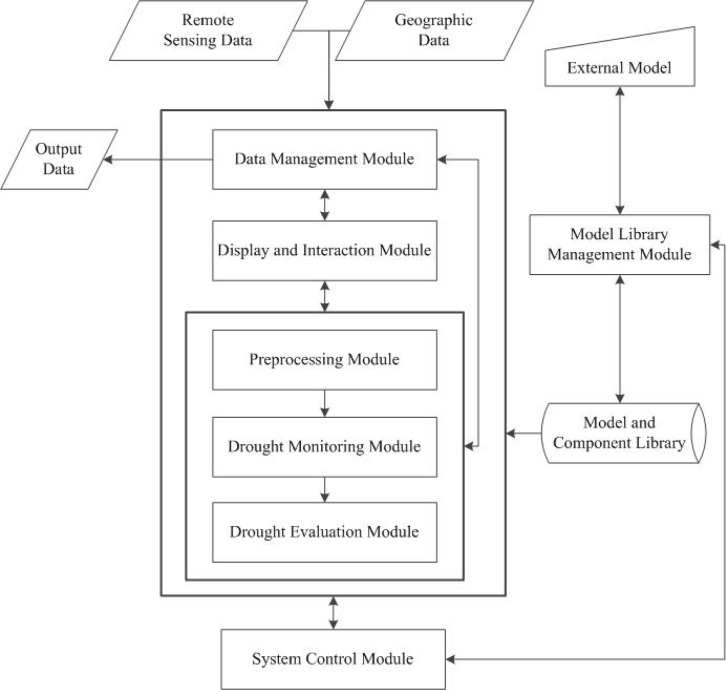
System workflow.